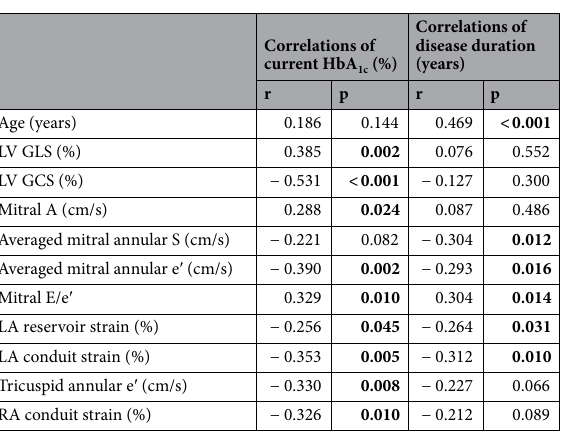
Table 2. Significant univariate predictors of the echocardiographic variables in the T1DM population: correlations of current HbA 1c and disease duration. Statistically significant p-values (p < 0.05) are formatted in